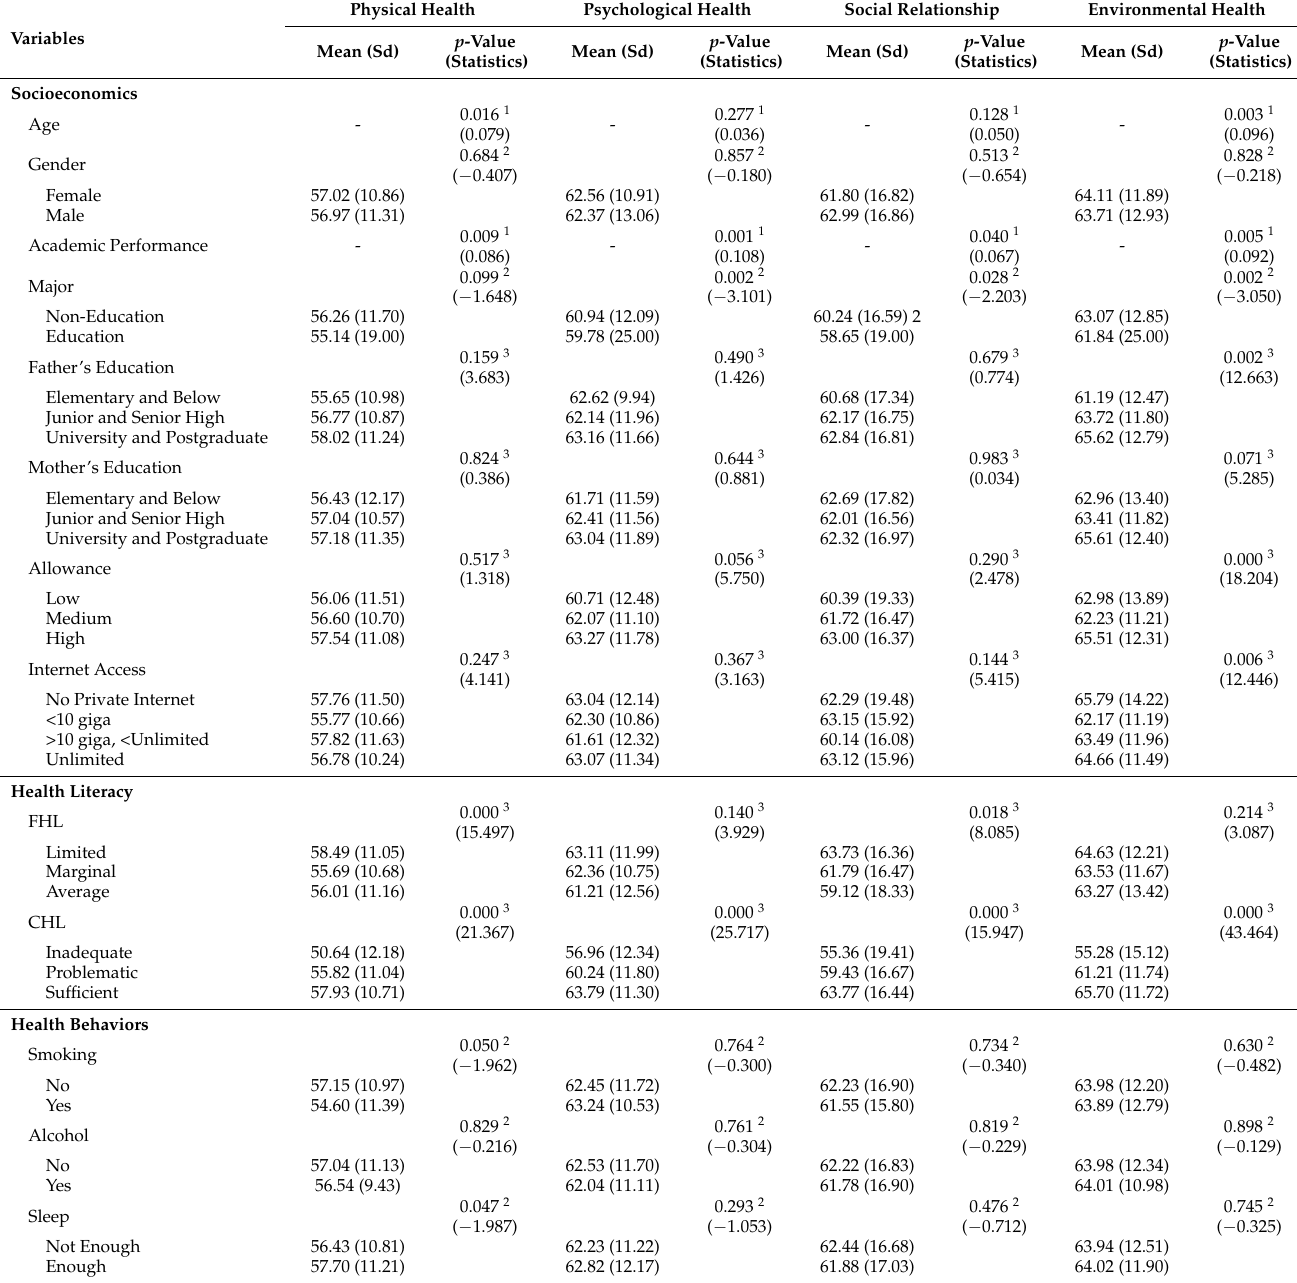
Table 2. Associations between quality of life to socioeconomic determinants, HL, HBs, and